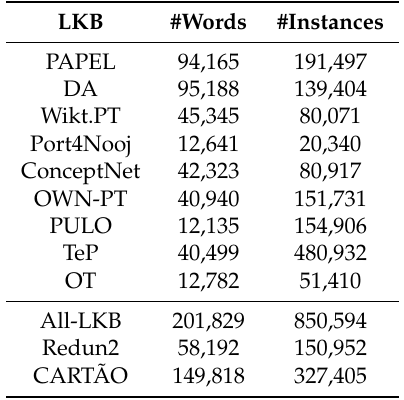
Table 4. Size of the LKBs used in terms of words and relation